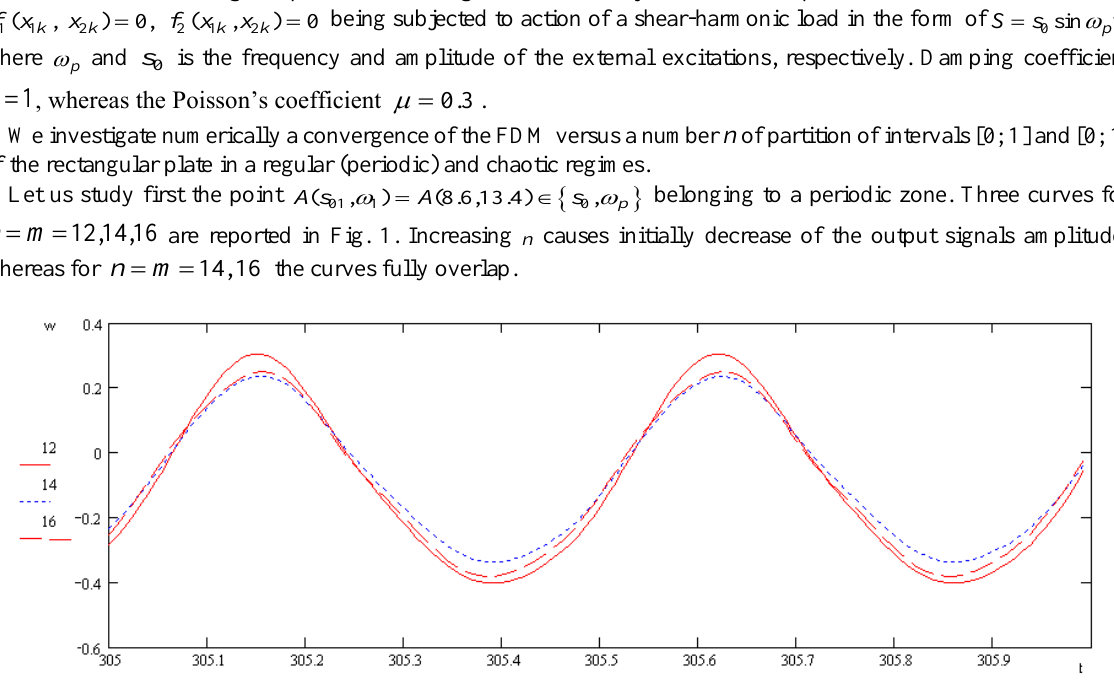
Fig. 1. Deflection ( ) w t versus n in a periodic